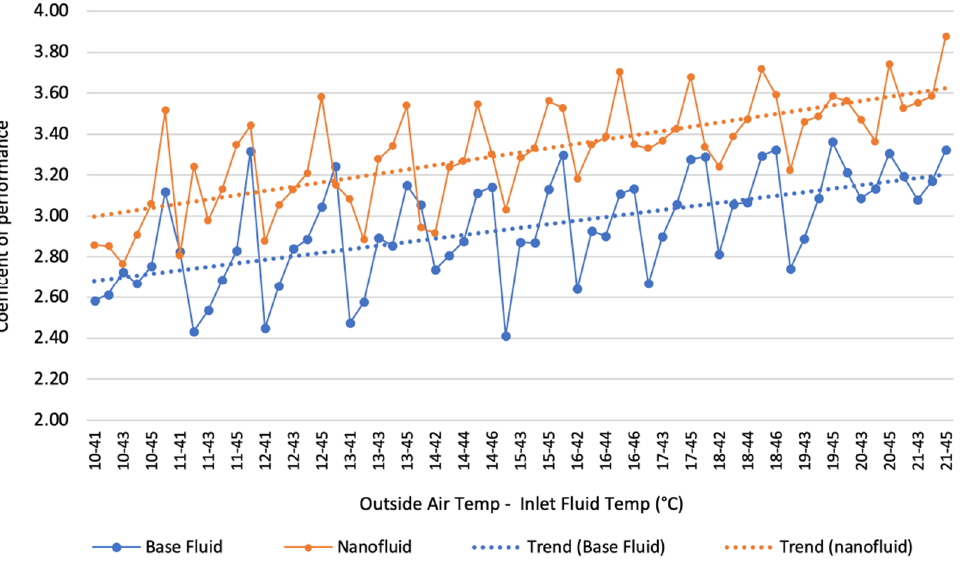
Figure 13. Average COP of HVAC-1 working with base fluid and nanofluid (January 2021–March